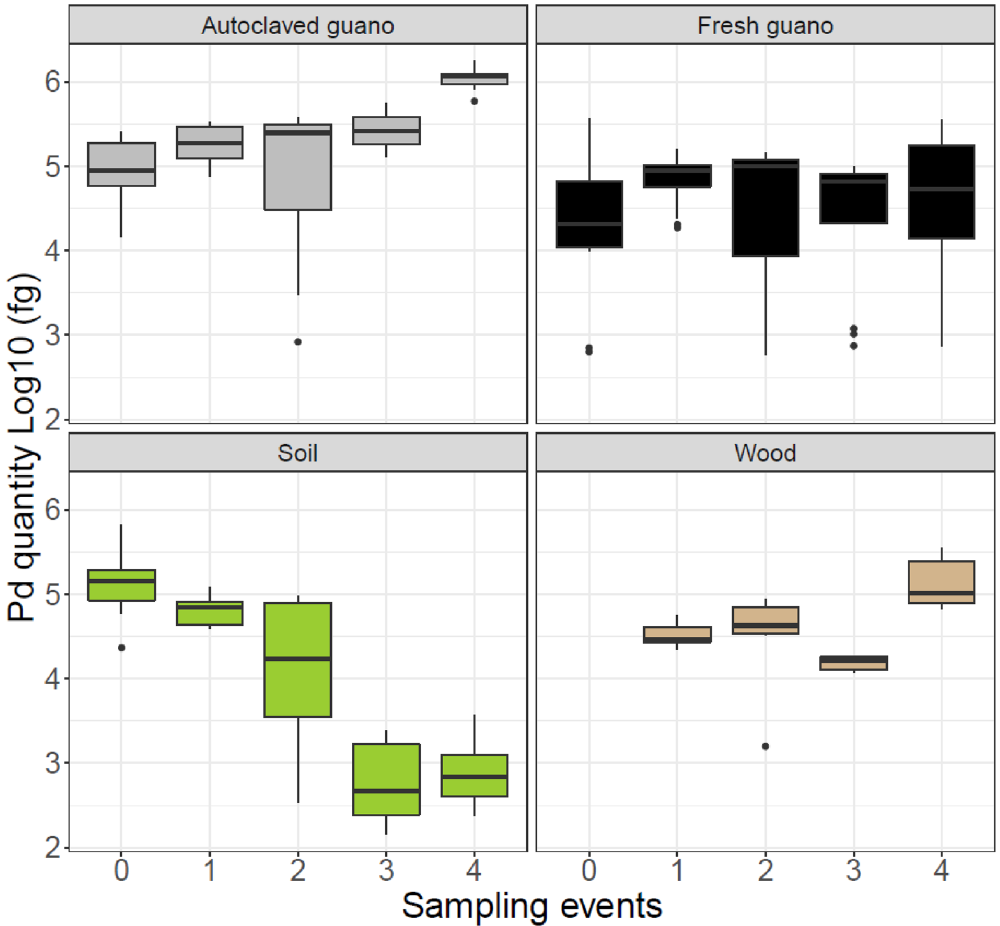
Figure 2. Pd fungus growth on different substrates over 64 days for five different sampling events (Day 0, 16, 32, 48 and 64). To facilitate comparison with the same extraction kit, we only present data for wood corresponding to values obtained using the QIAGEN Blood and Tissue extraction Kit. We discovered substantially lower yield with the Prepman Ultra Reagent after the first sampling event and initiated sampling with both Prepman and QIAGEN kits for all subsequent sampling